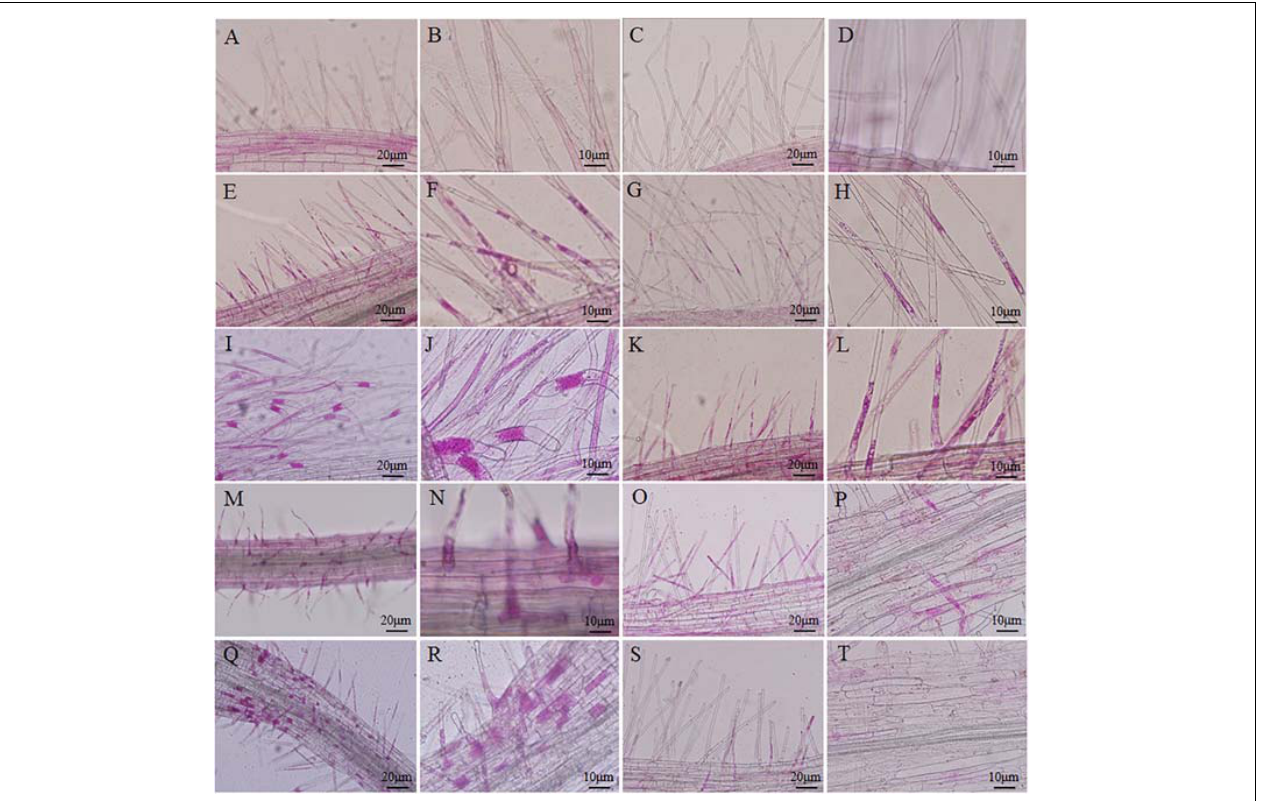
FIGURE 2 | Infection dynamics in the root hairs of resistant and susceptible plants. Root segments were stained with Phloxine B. Staining in the root hairs indicated the presence of root hair infection. (A,B,E,F,I,J,M,N,Q,R) Segments of roots of Brassica napus . (C,D,G,H,K,L,O,P,S,T) Segments of roots of Matthiola incana . (A–D) Segments of control roots. (E–H) Segments of inoculated roots at 3 days after inoculation (DAI). (I–L) Segments of inoculated roots at 7 DAI. (M–P) Segments of inoculated roots at 10 DAI. (Q–T) Segments of inoculated roots at 14 DAI. Adjustments for magnification and illumination were performed to allow optimal viewing of the individual sections.